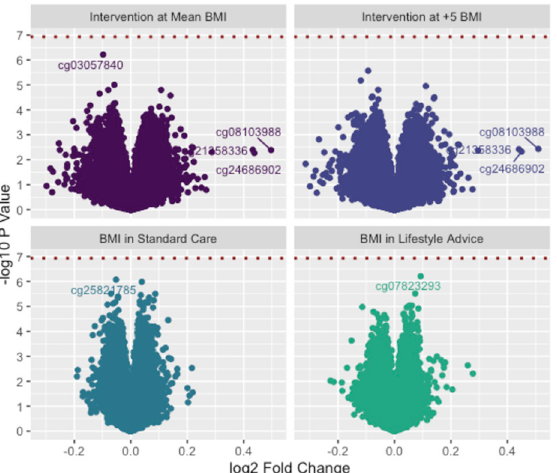
Fig 1. Volcano plots (-log10 p value vs log2 fold change) for intervention effects (at mean BMI and at +5 kg/m2 BMI) and BMI effects (in lifestyle advice and standard care groups).